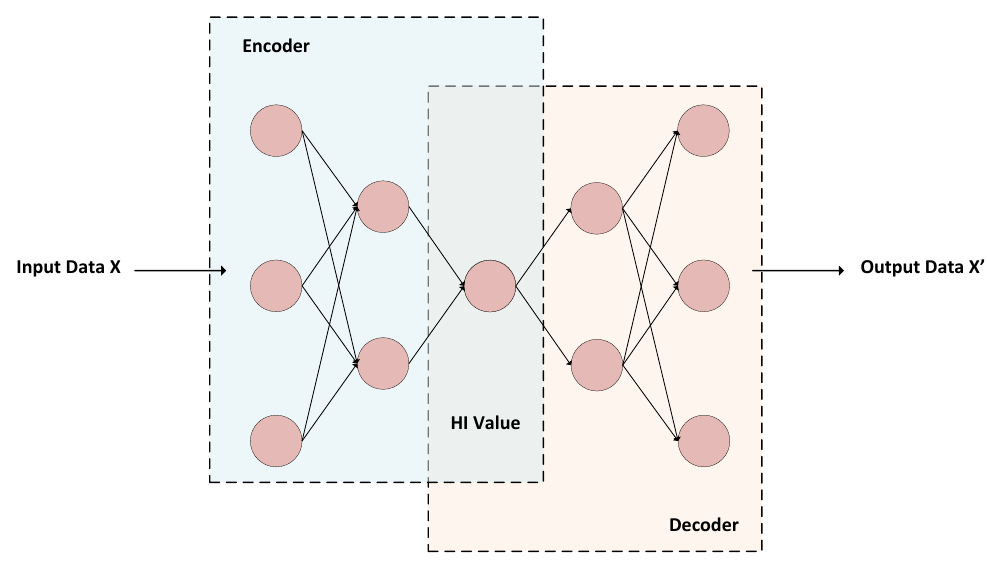
Figure 2. SAE structure.